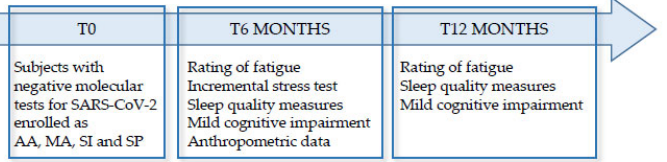
Figure 1. Schematic illustration of the study design. Subjects enrolled were tested as described in the boxes at 6 and 12 months after the end of COVID-19 acute infection.